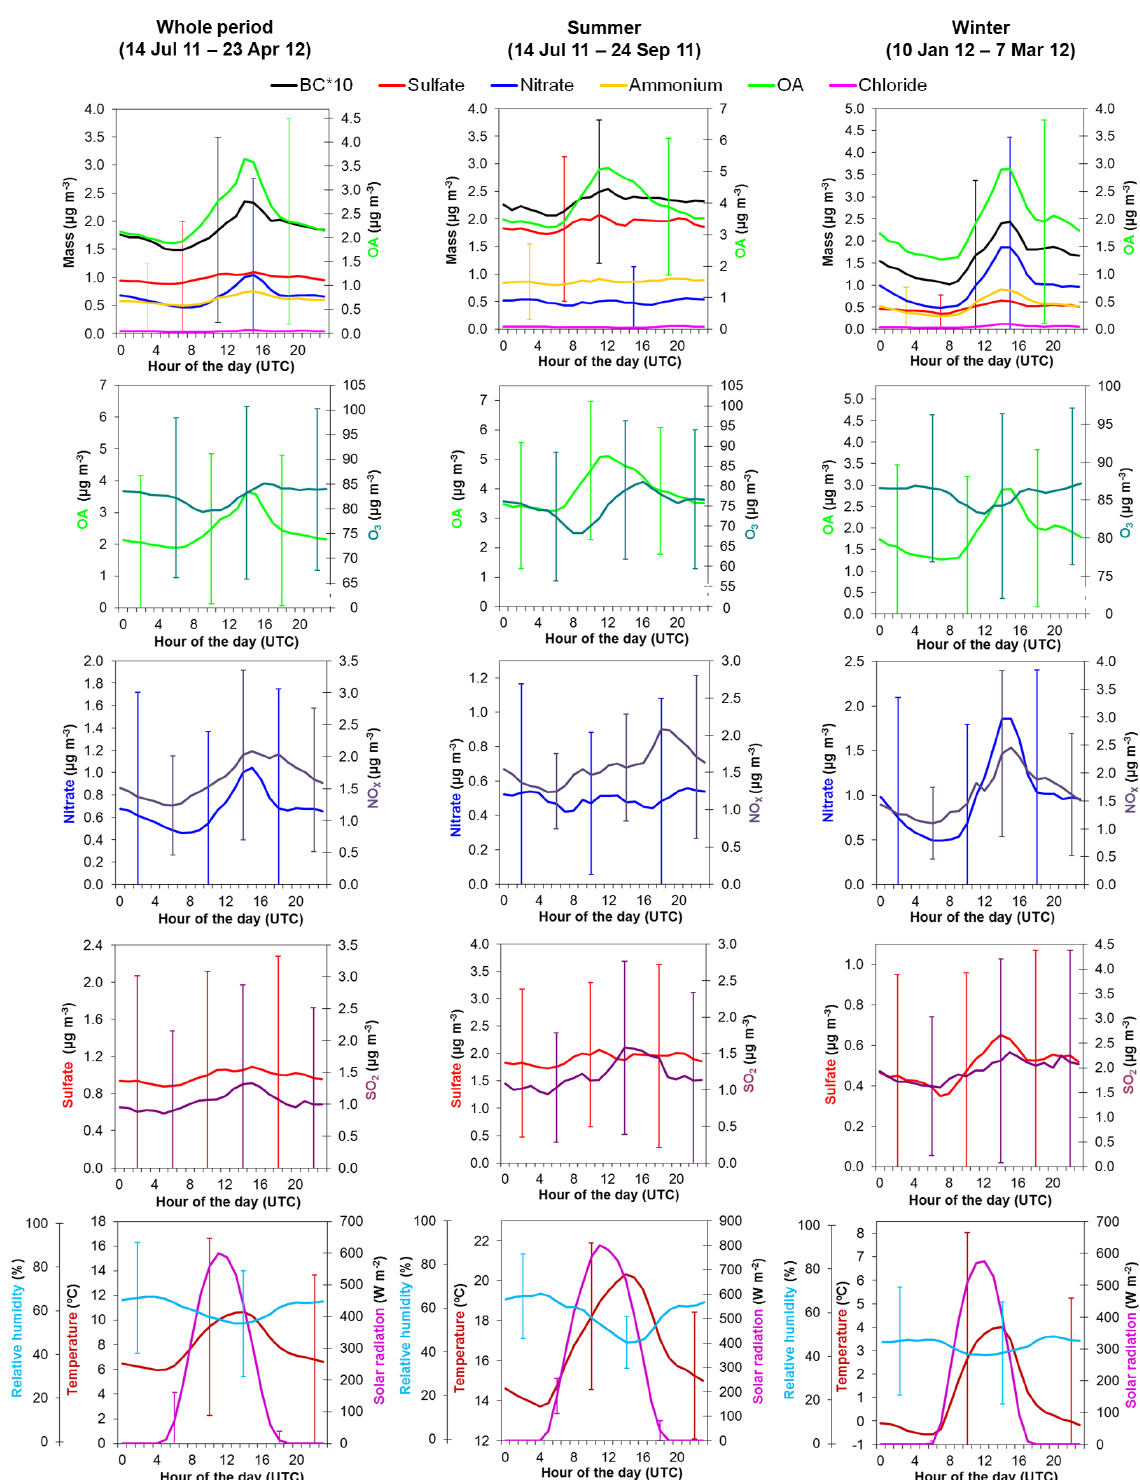
Figure 6. Diurnal cycles of PM 1 chemical species (BC, sulfate, nitrate, ammonium, chloride and OA), gaseous pollutants (O 3 , NO x , and SO 2 ), and meteorological parameters (relative humidity, temperature and solar radiation) averaged for the whole period, summer and winter. Variation bars indicate ± standard